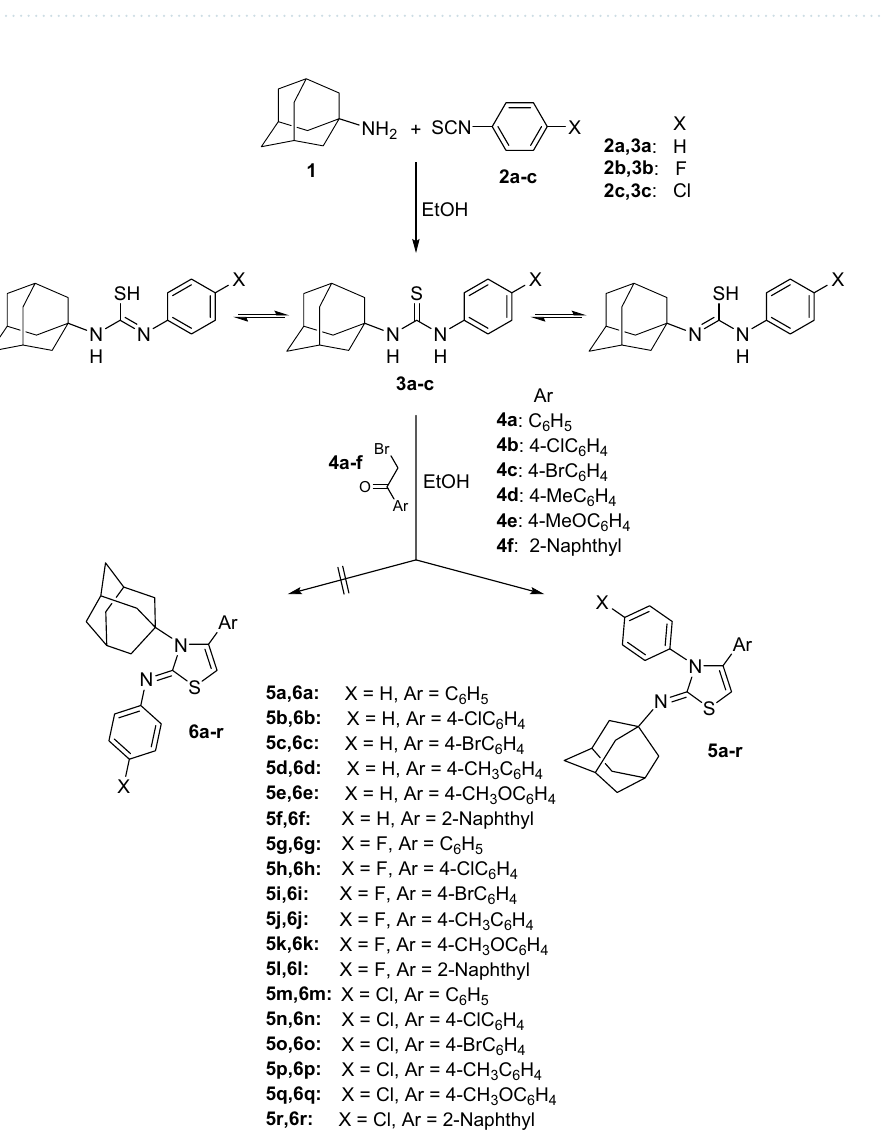
Figure 2. Thiazole-based anticancer drugs.